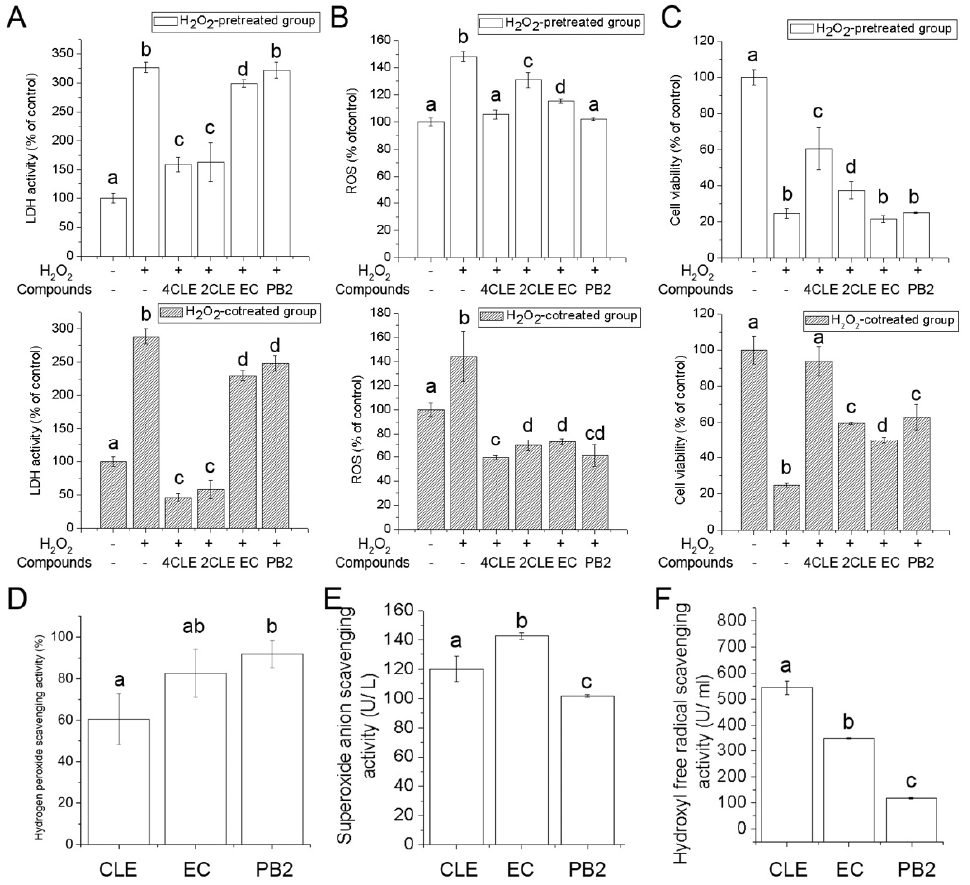
Figure 4. Antioxidant activities of CLE, EC, and PB2. ( A ) The effects on the lactate dehydrogenase (LDH) release of 0.5 mM H 2 O 2 -pretreated or co-treated RAW 264.7 cells; ( B ) The effects on the intracellular reactive oxygen species (ROS) levels of 0.5 mM H 2 O 2 -pretreated or co-treated RAW 264.7 cells; ( C ) The effects on the viability of 1 mM H 2 O 2 -pretreated or co-treated RAW 264.7 cells; ( D – F ) The hydrogen peroxide and free radical scavenging activities of CLE, EC, and PB2. The same letter within each column indicates no significant difference ( p > 0.05). 4CLE (2CLE) is short for 400 (200) µ g/mL CLE. The dosages of EC and PB2 were identical amount of EC and PB2 in 400 µ g/mL CLE, which were 120 µ g/mL and 34.4 µ g/mL,